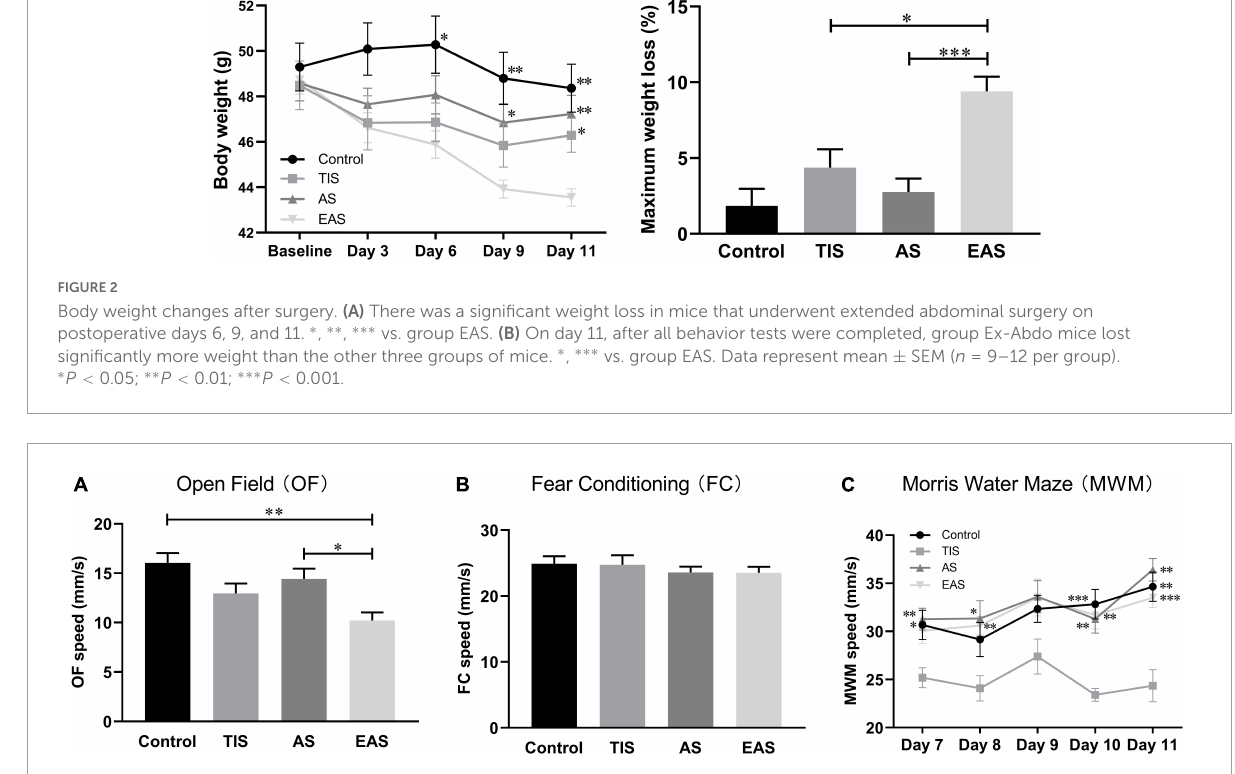
harvested for ELISA of TNF- α , IL-6, and IL-1 β cytokines. The results showed that inflammatory cytokines had no significant differences between the groups ( Figure 6 ), indicating that hippocampal inflammation was not significantly affected by either surgery type on day 12.